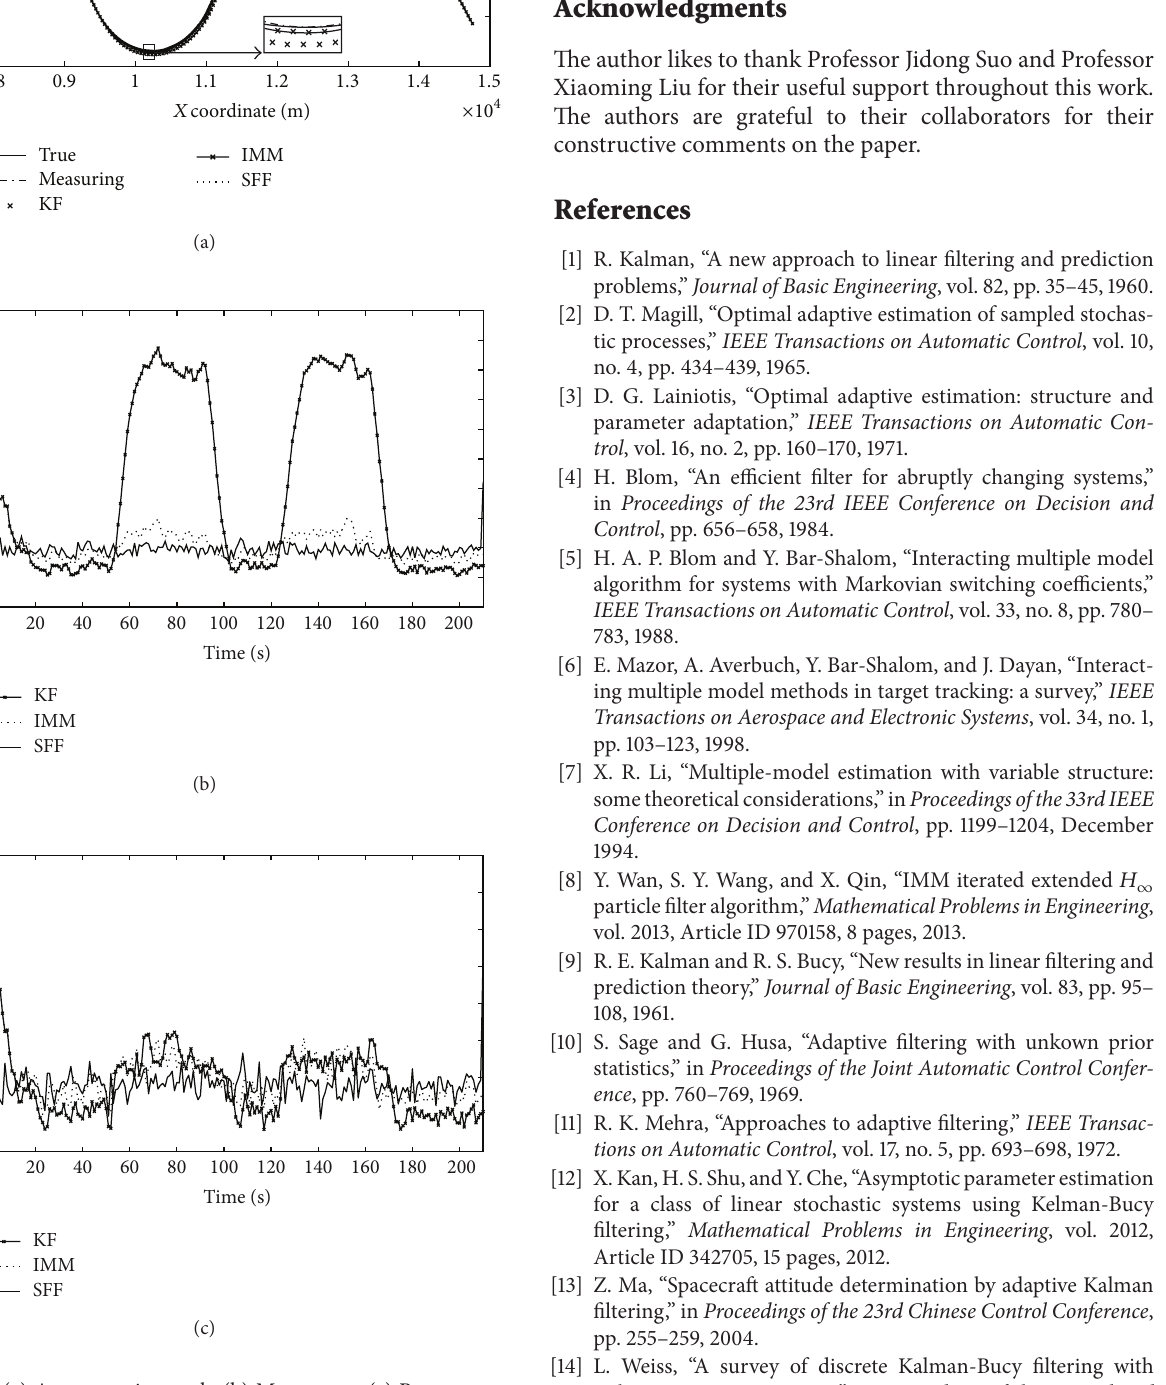
Figure 5: (a) Average point track. (b) Mean error. (c) Root-mean- square error.